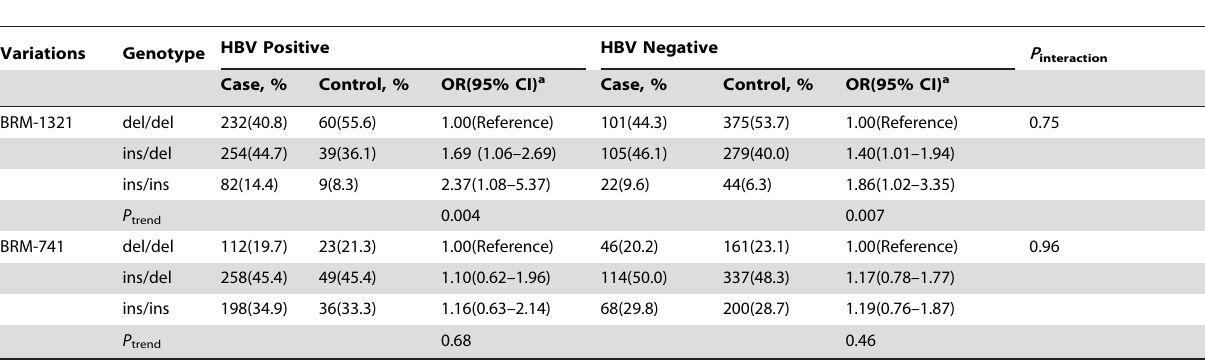
Table 5. Stratification analysis based on HBV infection